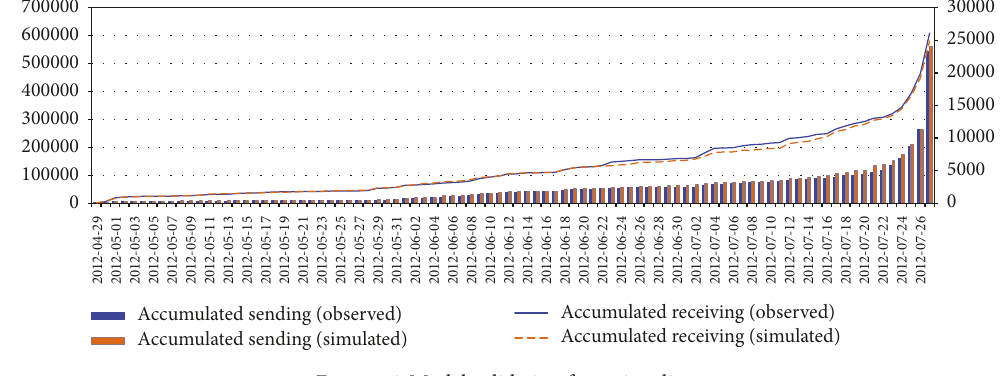
Figure 6: Model validation from time line.